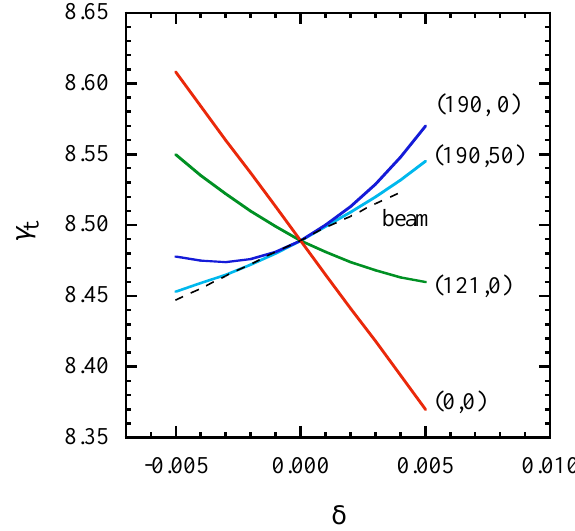
FIG. 1. (Color) Predicted momentum dependence of g (cid:116) as a function of horizontal sextupole and octupole current ( (cid:73) (cid:72)(cid:115) (cid:44) (cid:73) (cid:79) ).